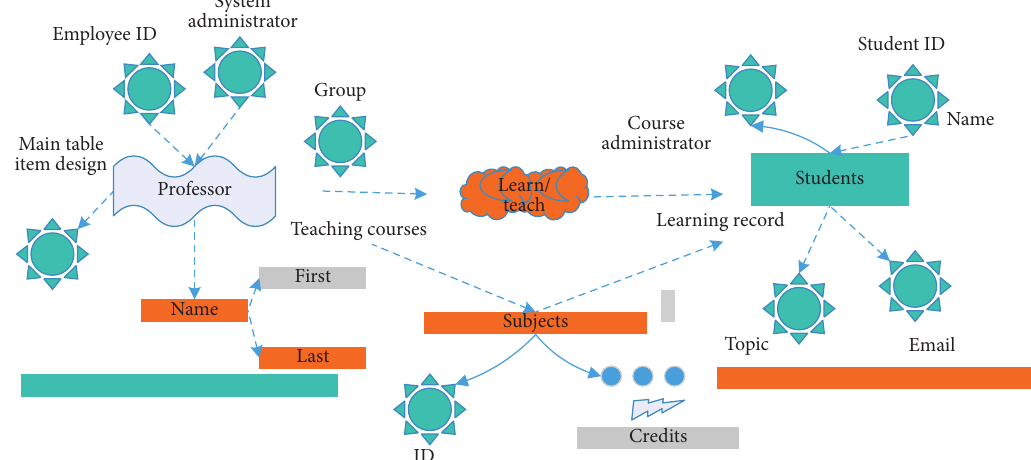
Figure 2: Conceptual ER diagram of teaching system